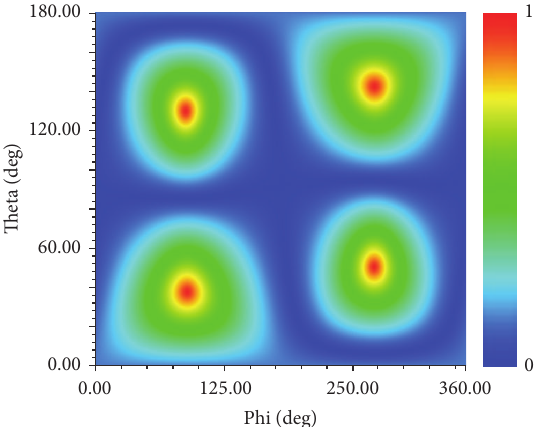
Figure 32: Axial ratio (AR) in linear scale of the 3D spherical antenna (Table